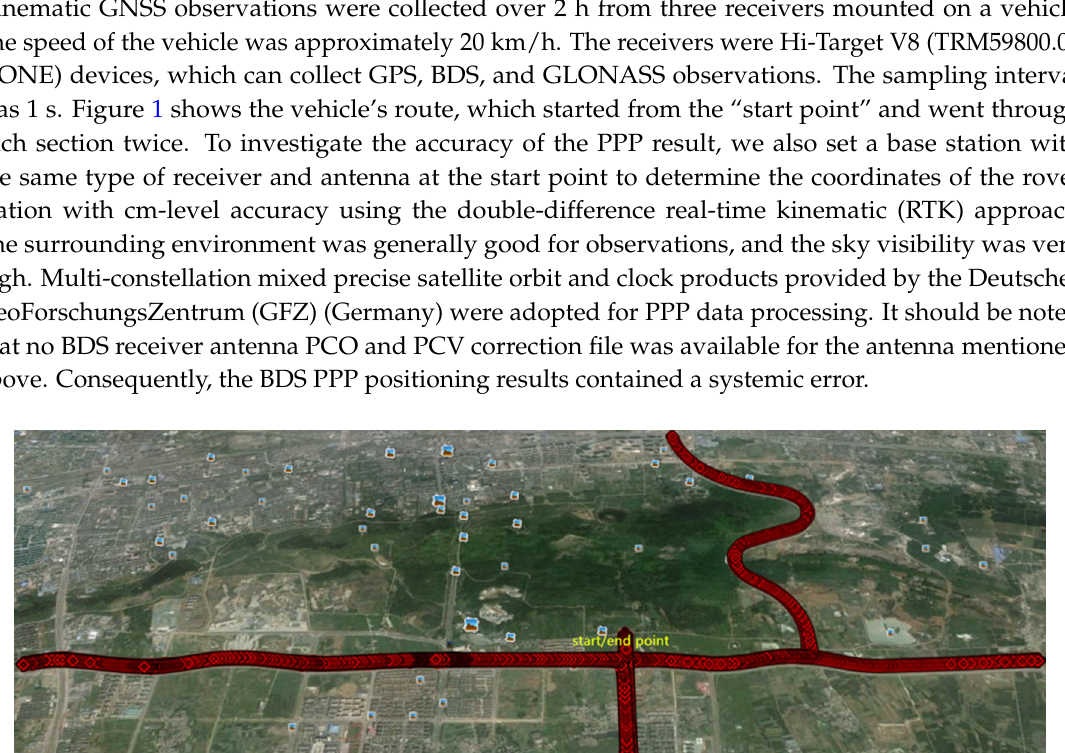
Figure 2. Numbers of satellites and positional dilution of precision (PDOP) values of multi-constellation PPP. BDS: BeiDou Navigation Satellite System; GLONASS: Globalnaya Navigatsionnaya Sputnikovaya Sistema; GPS: global positioning system; G: GPS only; G + R: GPS/GLONASS combination; G + C: GPS/BDS combination; G + R + C: GPS/GLONASS/BDS combination.